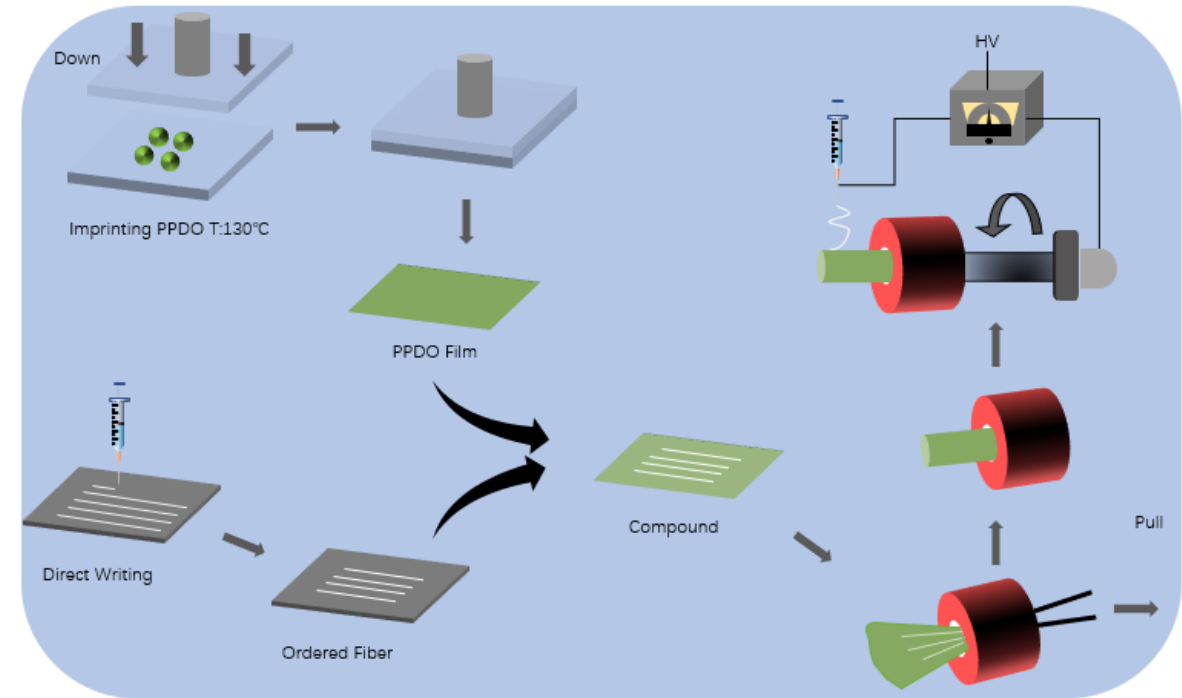
Figure 1. Process flow chart of preparation of small-diameter blood vessels.